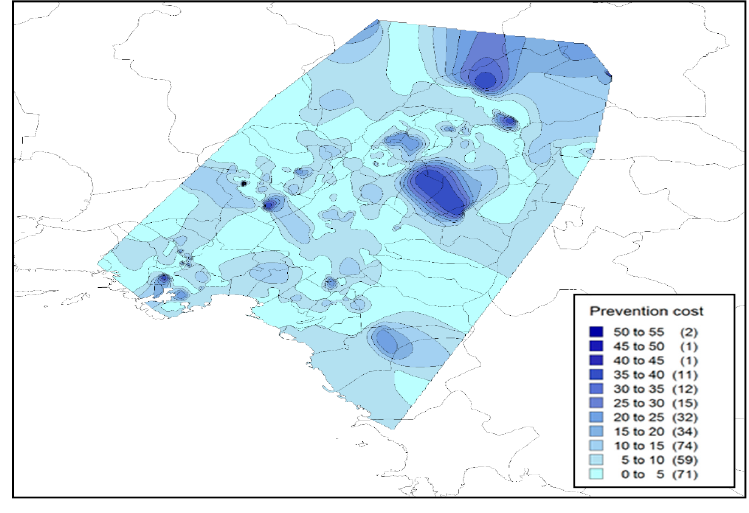
Figure 7. Annual prevention costs in Athens metropolitan area (€/year/household). Table 3. Correlation of prevention costs and nuisance